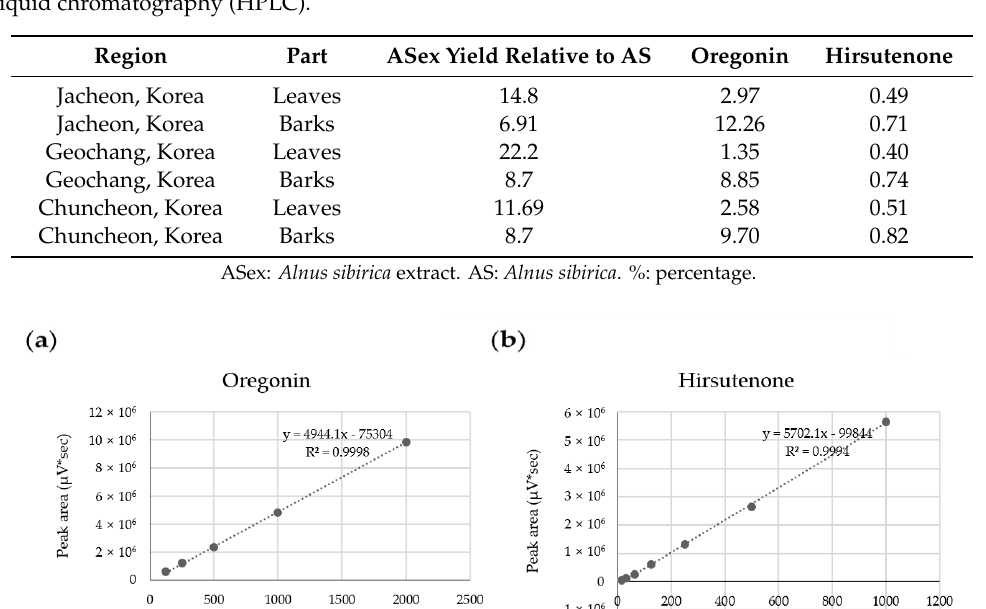
Table 1. ASex yield (%) and indicator content (%) from each region determined by high-performance liquid chromatography (HPLC).